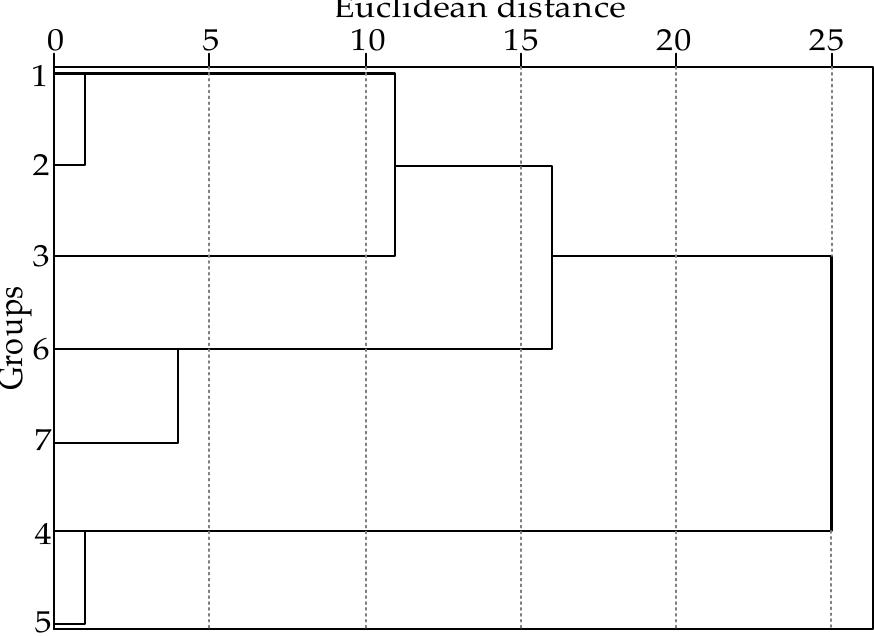
Figure 4. HCA of the volatile flavor substances in the seven kinds of pepper oil.